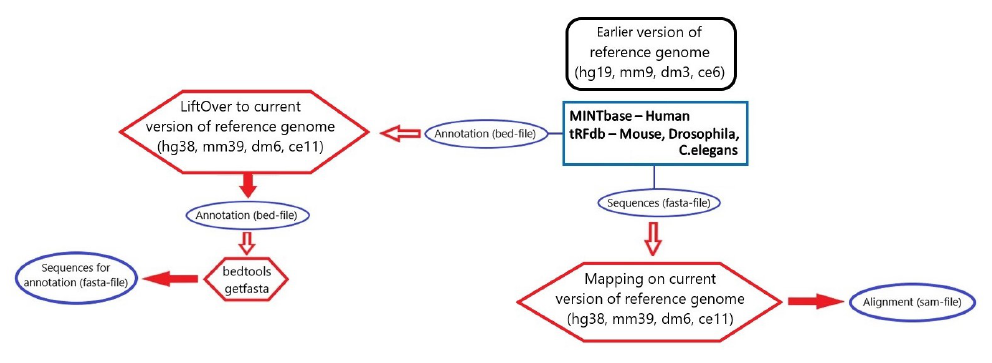
Figure 7. An overview of all processing steps for integration of tsRNA data for four